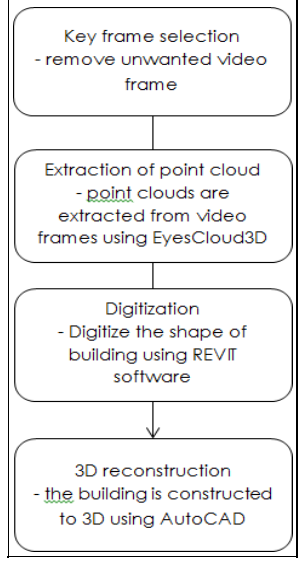
Figure 11 Flow chart of data